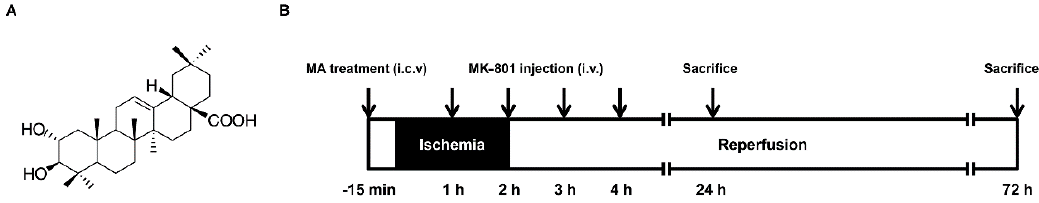
Figure 1. ( A ) Chemical structure of maslinic acid; ( B ) Schematic representation showing the timeline of the experimental protocols. Maslinic acid was administered intracerebroventricularly (i.c.v.) 15 min before MCAO. MK-801 was administered at the indicated time points after the induction of ischemia through intravenous injection (i.v.).